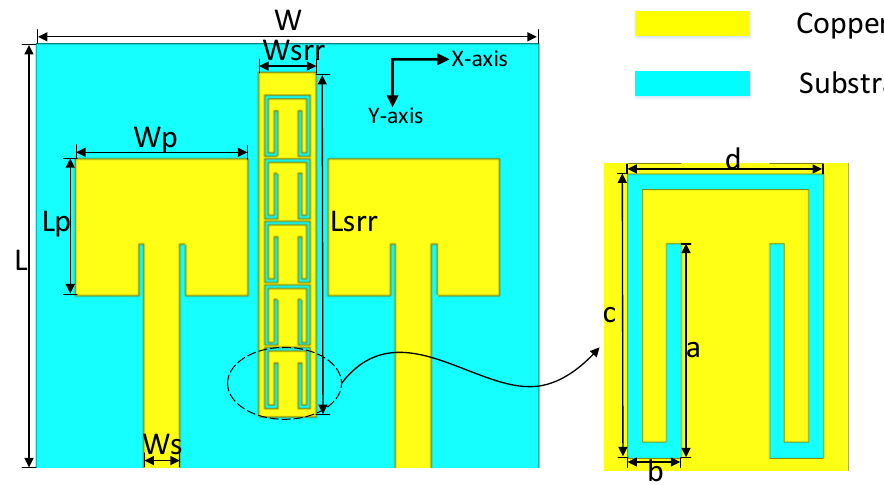
Figure 1. Top view of the proposed Multiple Input Multiple Output (MIMO) Antenna.